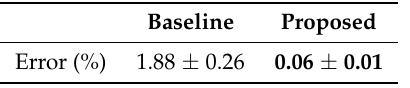
Table 7. GSD prediction errors of the mixed dataset experiment.